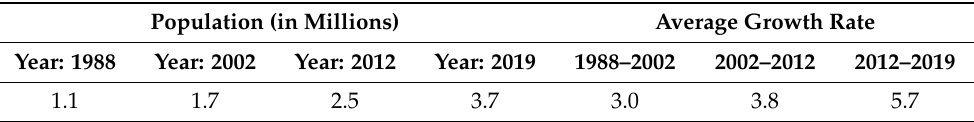
Figure 4. Population growth trend of Dar es Salaam and Msimbazi (1988–2019). Table 7. Population census and growth rate of Msimbazi (1988–2019). Population (in